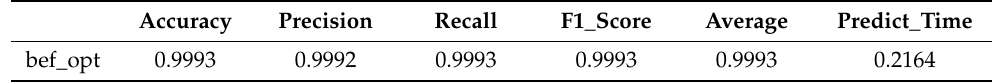
Table 6. Performance indicators before RF optimization.